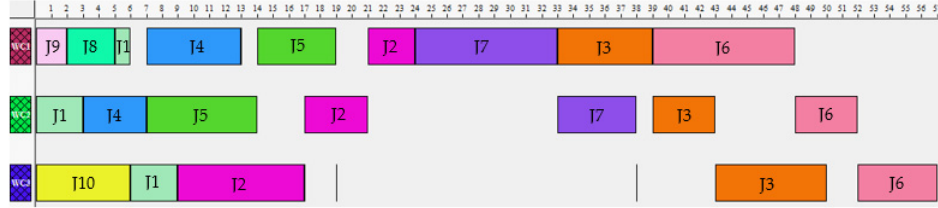
Figure 7. Gantt chart about the best solution found for scenario 1 (about problem instance 5).